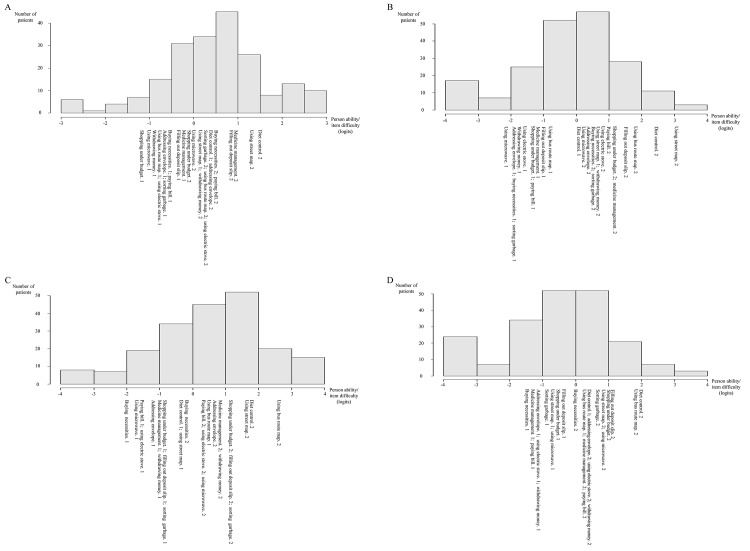
Item-person map.(A) volition; (B) planning; (C) purposive action; and (D) effective performance. The numbers after the decimal point for each item indicate the step difficulty. In a 3-point scale (0–2), for example, “diet control. 1” represents the first step difficulty (between response categories 0 and 1) of the “diet control” item and “diet control. 2” represents the second step difficulty (between response categories 1 and 2).